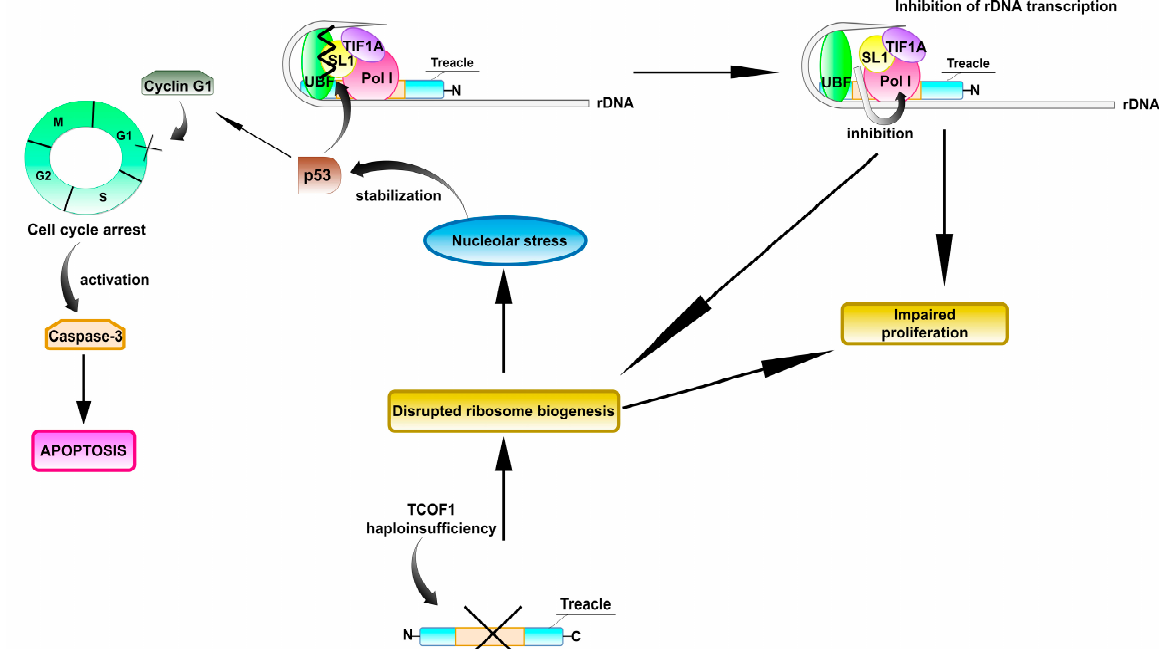
Figure 5. The model of TCOF1 haploinsufficiency leading to TCS proposed by Jones et al. [82]. TCOF1 haploinsufficiency leads to disruption of ribosome biogenesis, impaired proliferation, and apoptotic loss of neuroepithelial and neural crest cells. This mechanism is further boosted by p53 tumor suppressor, which is stabilized in response to the nucleolar stress. p53 prevents the interaction between SL1 (promoter selectivity factor 1) and UBF, leading to inhibition of RNA polymerase I activity and attenuation of rRNA transcription [83]. This in turn leads to the reduced ribosome biogenesis and attenuated proliferation. On the other hand, p53 activates the transcription of cyclin G1, which leads to cell-cycle arrest in G1 phase, with the following induction of apoptosis. The apoptotic loss of neural crest precursors leads to craniofacial abnormalities and TCS development. Importantly, inhibition of p53 function in mouse TCS embryos reduces the activation of cyclin G1 and consequently attenuates apoptosis, preventing TCS in TCOF1 +/ − embryos. The above mechanism has been described by Jones et al. [82] as a mechanistic model describing the molecular background of TCS pathogenesis. Later studies revealed that treacle loss also results in dysfunction of Polo-like kinase 1 (Plk1), leading to mitotic arrest and cell cycle delay of developing brain neurons and contributing to the TCS neurodevelopmental disorders such as microcephaly [25]. Another postulated mechanism of TCOF1 haploinsufficiency resulting in TCS could be lowered rRNA production and global reprogramming of cellular translation program [32] (see text for details).